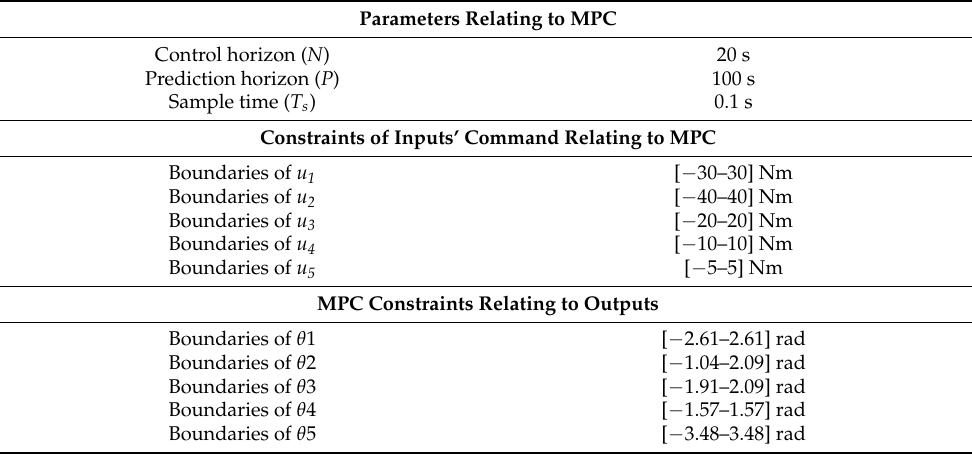
Table 5. MPC parameters relating to the RV-2AJ robot arm .